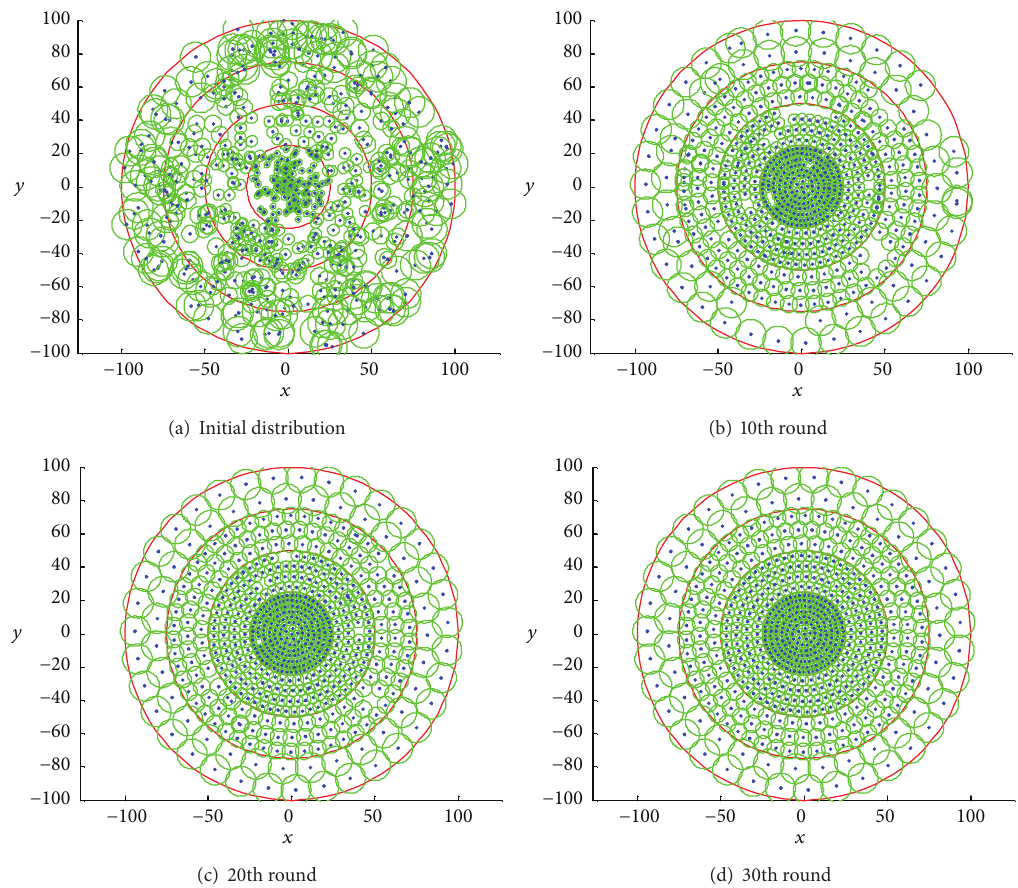
Figure 4: Illustration of network distribution in different rounds using random deployment